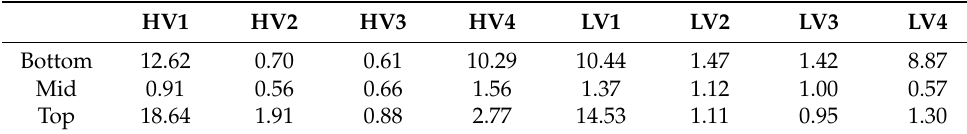
Table 5. The change multiples of radial peak resultant forces of Table 4. The change multiples of axial peak resultant forces of windings.